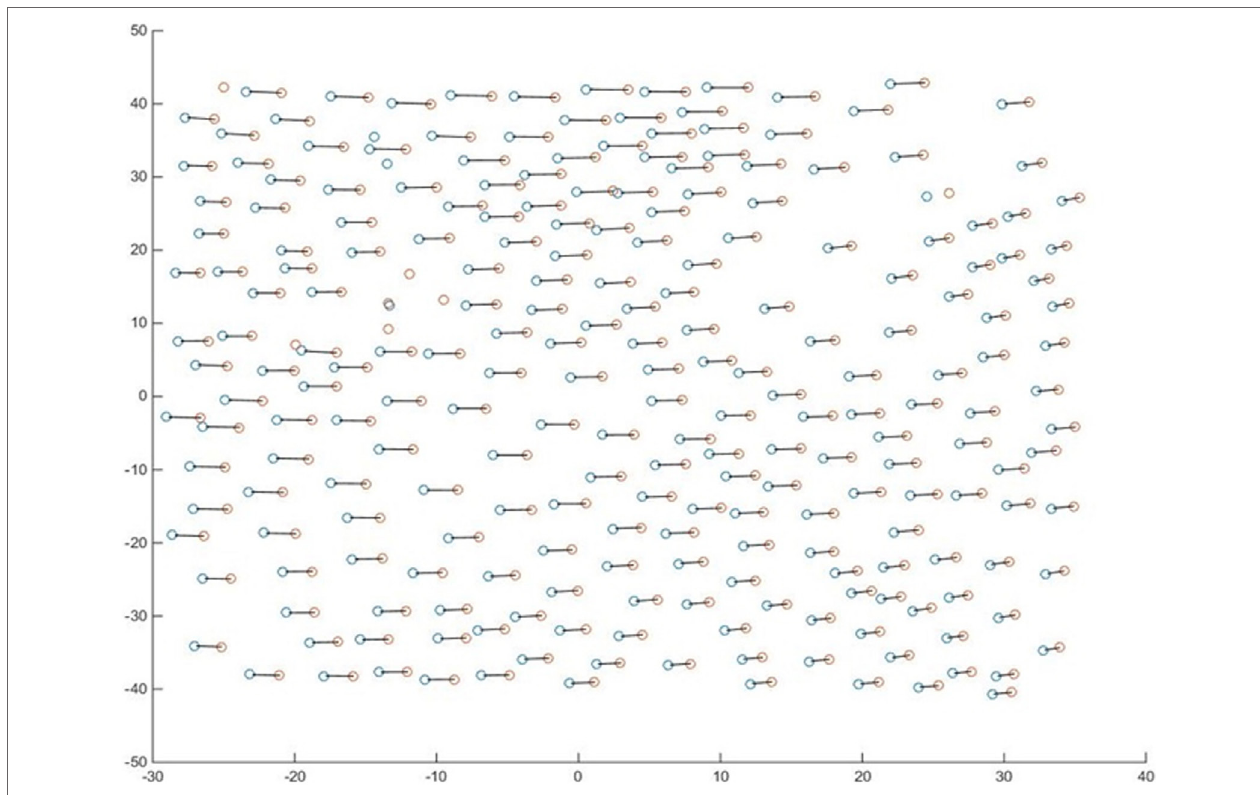
FIgURe 10 | Detected markers on both cameras (blue and red circles) are shown in x (cm) and y (cm) coordinates, per calibration. Matches found on both images of an image pair are connected by lines. The rest are considered false points and are